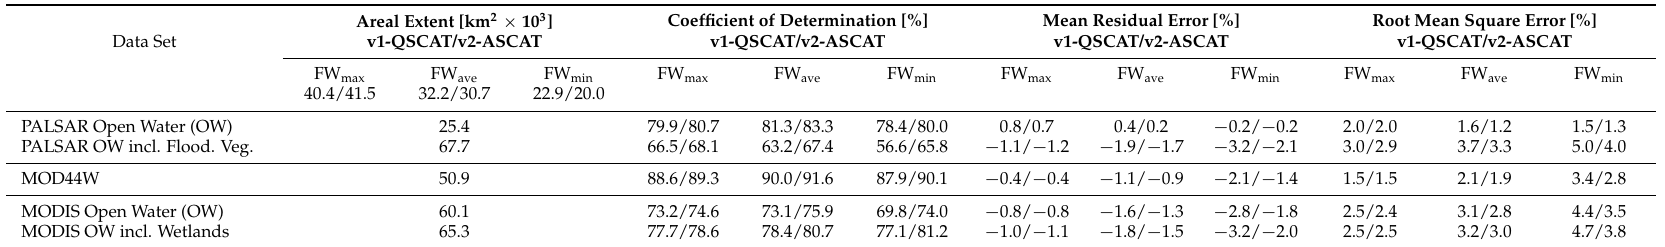
Table 7. Areal extent and summary statistics from pixel-wise comparisons of fractional water (FW) generated from v1-QSCAT (2000–2008) and v2-ASCAT (2009–2012) average annual maximum (FW max ), mean (FW ave ), and minimum (FW min ) record periods against maps of open water (OW) and flooded vegetation derived from the Advanced Land Observing Satellite (ALOS) Phased Array type L-band Synthetic Aperture Radar (PALSAR) ScanSAR Amazon maximum inundation extent map and subsets of static FW from the MOD44W and MODIS including wetlands products for a section (8.5 ˝ S–1 ˝ N, 55.5 ˝ W–74.5 ˝ W) of the central Amazon river floodplain. Relationships are significant at a minimum 0.01 probability